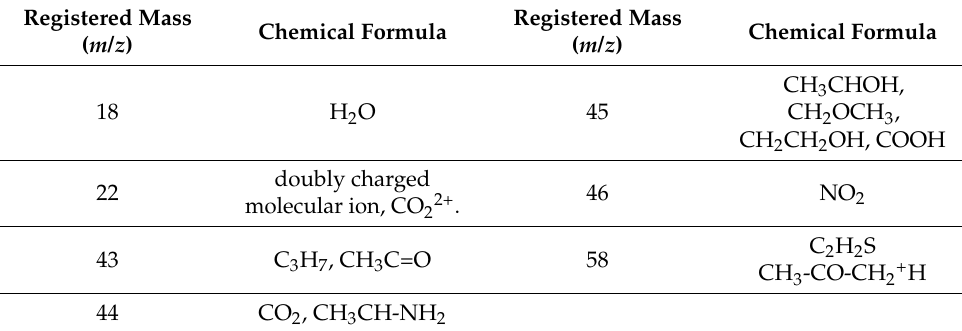
Table 2. Volatile ions released from filters identified by QMS during thermal analysis process.